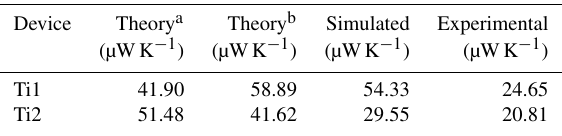
Table 5. A comparison of the total thermal conductance of the de- vices at atmospheric pressure.